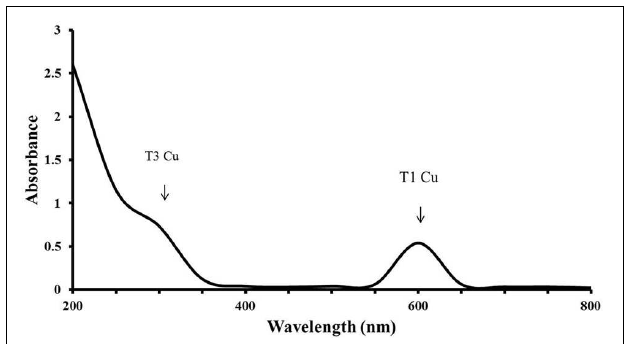
FIGURE 7 | UV-VIS absorbance spectrum of LccH. A broad peak at 600 nm and a shoulder at 330 nm shows the T1 and T3 Cu 2 center, respectively.